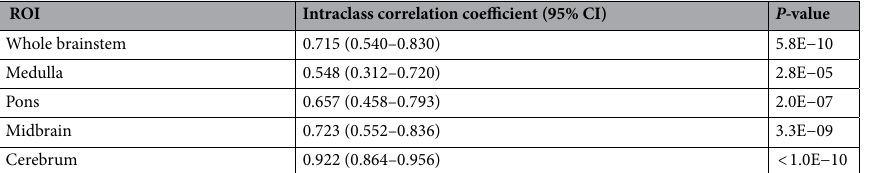
Table 4. Reliability of the model tested on 47 healthy adults from Group B. Intraclass correlation coefficients, calculated using a two-way mixed effects model for single measures (absolute agreement), were used to assess the reliability of the model, i.e., the correlations between measured and corresponding expected normal healthy volumes. ROI Region of interest, CI Confidence interval.